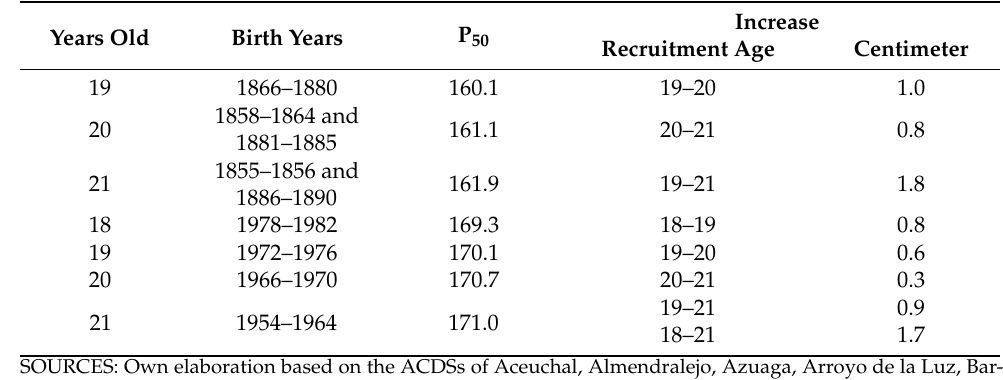
Table 1. Increase in the mean age of the recruits included in the sample Extremadura (1855–1890 and